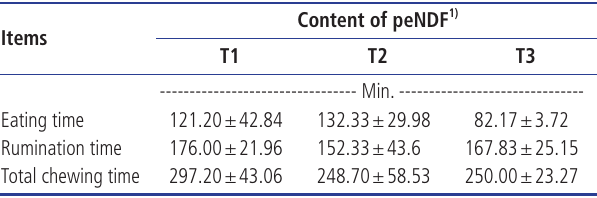
Table 7. Chewing activity of Korean native goats fed the TMR feeds with different peNDF contents